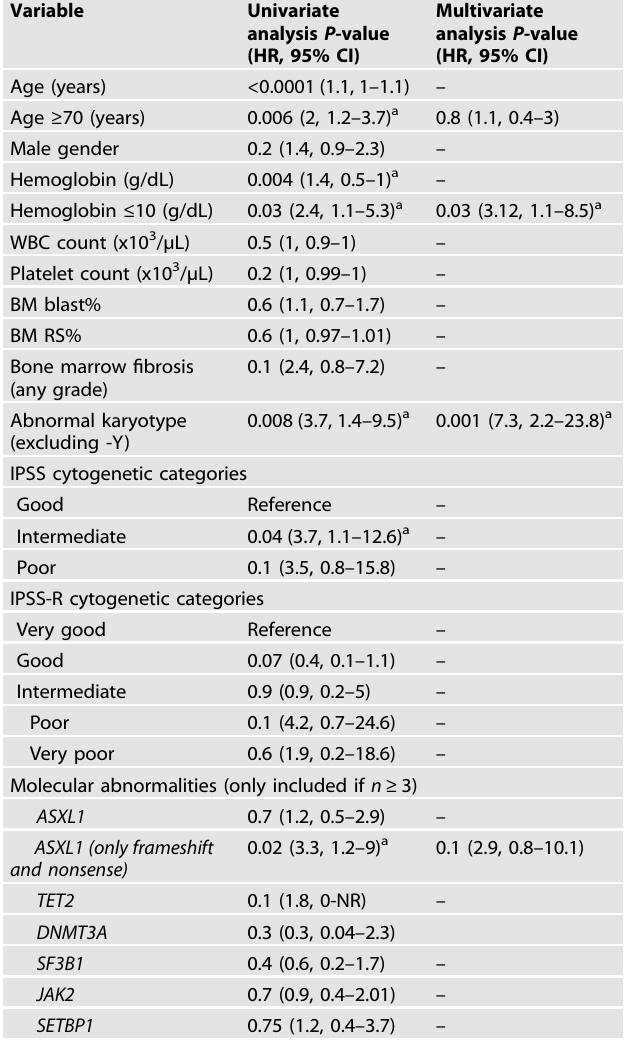
Table 2. Univariate and multivariate analysis of clinical and genomic characteristics among patients with